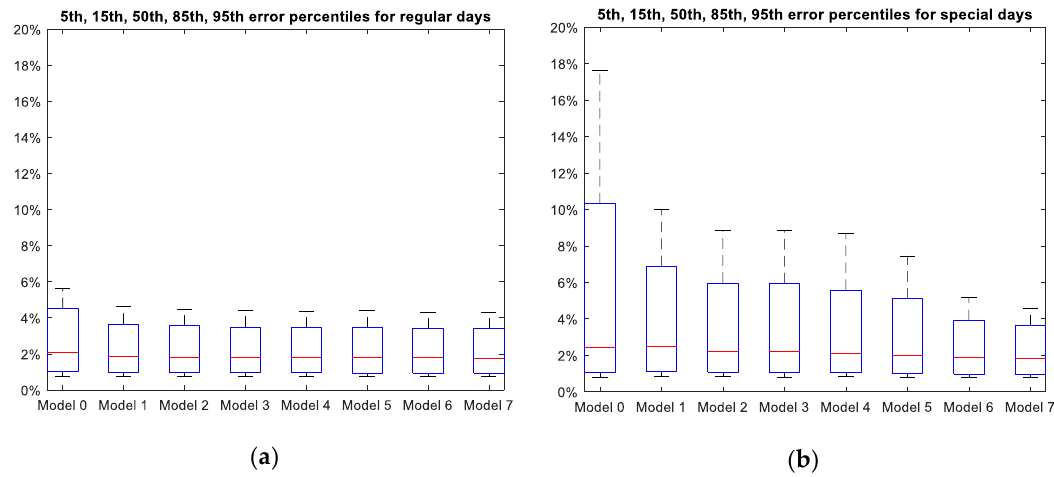
Figure 19. ( a ) Boxplot of the distribution of the error on regular days ( b ) Boxplot of the distribution of the error on special days.